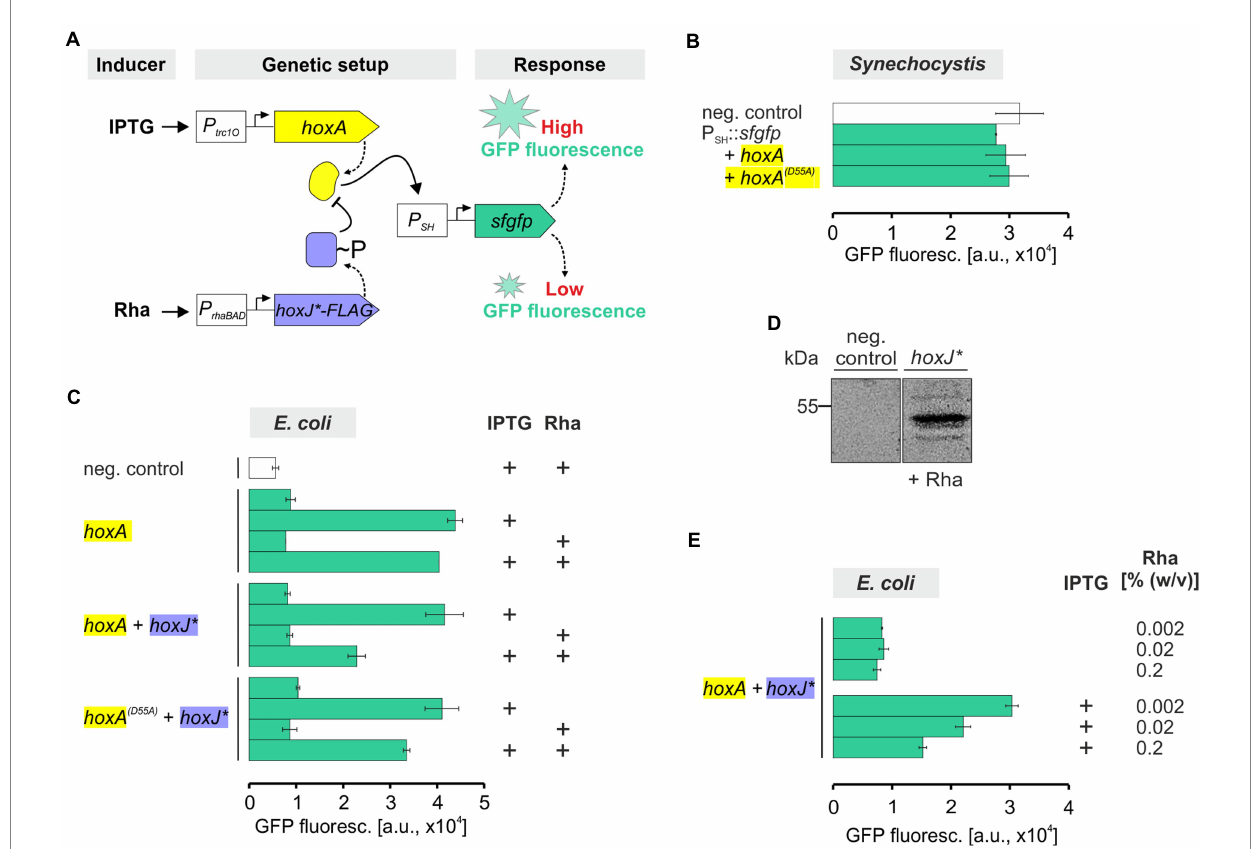
FIGURE 6 GFP fluorescence of E. coli and Synechocystis representing transcriptional regulation via HoxA and its modulation by HoxJ*. (A) Genetic setup of the generated strains. Expression of hoxA was driven by the IPTG-dependent lac promoter derivative P trc1O (Huang et al., 2010). The expression of the hoxJ* gene, fused to a FLAG-tag encoding sequence, was performed using the L-rhamnose (Rha)-inducible promoter P rhaBAD (Behle et al., 2020). HoxA- dependent expression of a reporter was achieved by fusion of a sfgfp gene to the cognate promoter of the NAD + -reducing, soluble hydrogenase gene cluster of C. necator , P SH (Zimmer et al., 1995; Schwartz et al., 1998). HoxJ* in turn modulates HoxA-dependent transcriptional regulation (Lenz and Friedrich, 1998). (B,C,E) Whole-cell GFP fluorescence of recombinant Synechocystis or E. coli JM109 strains harboring the synthetic P SH ::sfgfp reporter gene construct in combination with different genetic information shown in panel A . Treatment with inducers IPTG and/or Rha prior to the measurements is indicated by ‘+.’ Detected fluorescence was normalized to OD 750 (panel B ) or OD 600 (panels C and E ) and is given in arbitrary units (a.u.). The particular negative controls (neg. control) contained a plasmid without reporter gene cassette. Data are the mean ± SD of at least two biological replicates (clones) each measured in technical triplicates. (D) Western blot confirming the presence of HoxJ*-FLAG (~54 kDa) in soluble protein extracts of E. coli JM109 harboring a P rhaBAD ::hoxJ* FLAG cassette versus an empty vector neg.